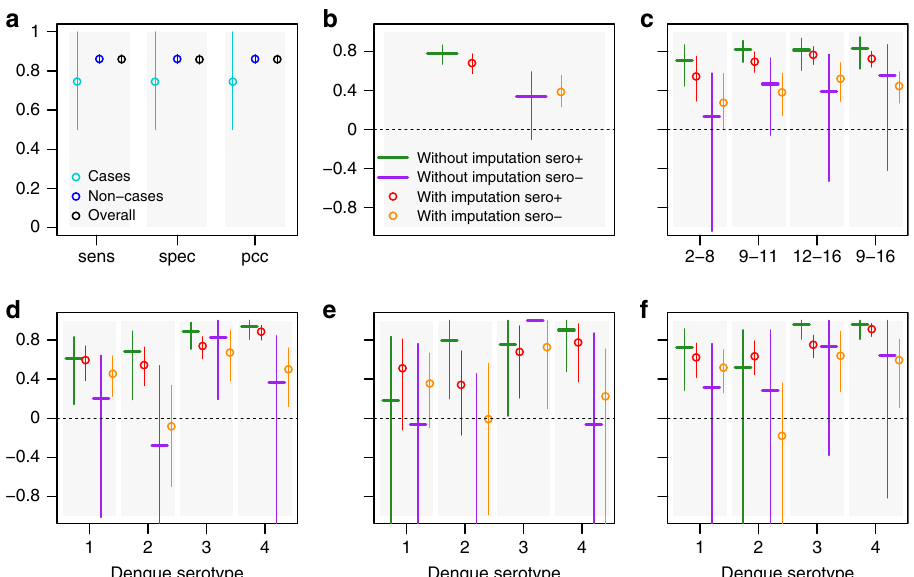
Fig. 1 Mean and 95% CI of vaccine ef fi cacy estimates with and without imputations for baseline seronegative (sero − ) and baseline seropositive (sero + ) subjects. Estimates were obtained from 1000 realisations of the fi nal BRT model trained on 50% of non-cases and 75% of cases and using 10-fold cross- validation, tc = 16, lr = 0.0005, bf = 0.75. a Sensitivity (sens), speci fi city (spec) and proportion of correct classi fi cations (pcc) among cases, non-cases and overall. b Vaccine ef fi cacy estimates for baseline seropositive and baseline seronegative subjects separately. c Vaccine ef fi cacy estimates for baseline seropositive and baseline seronegative subjects by age using 2 – 8, 9 – 11, 12 – 16 and 9 – 16 years age groups. d Vaccine ef fi cacy estimates by serotype for baseline seropositive and baseline seronegative subjects of all ages (2 – 16 years). e Vaccine ef fi cacy estimates by serotype for baseline seropositive and baseline seronegative subjects 2 – 8 years old. f Vaccine ef fi cacy estimates by serotype for baseline seropositive and baseline seronegative subjects 9 –